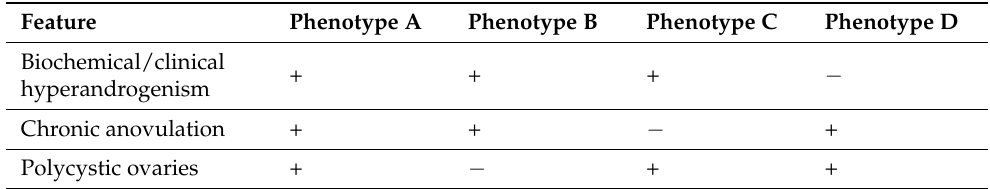
Table 1. Four major clinical phenotypes of